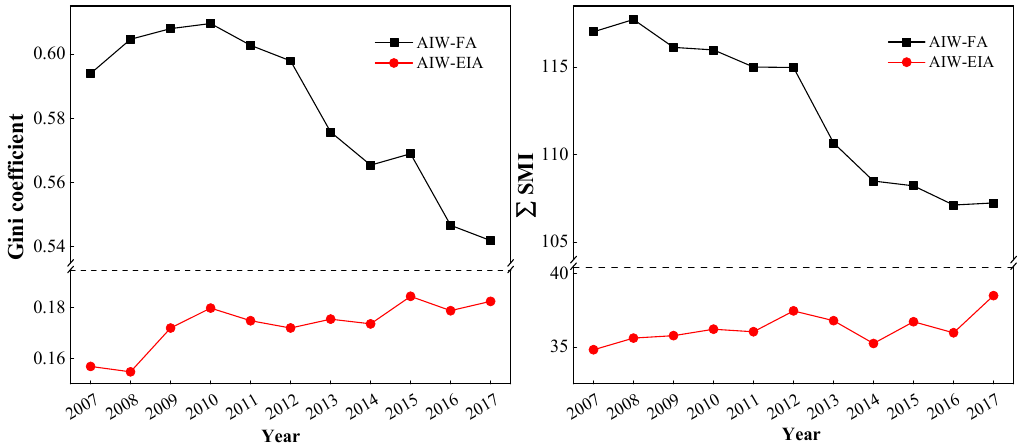
ffi cient and spatial mismatch index of agricultural water and land Figure 5. The Gini coefficient and spatial mismatch index of agricultural water and land resources. Figure 5. The Gini coe